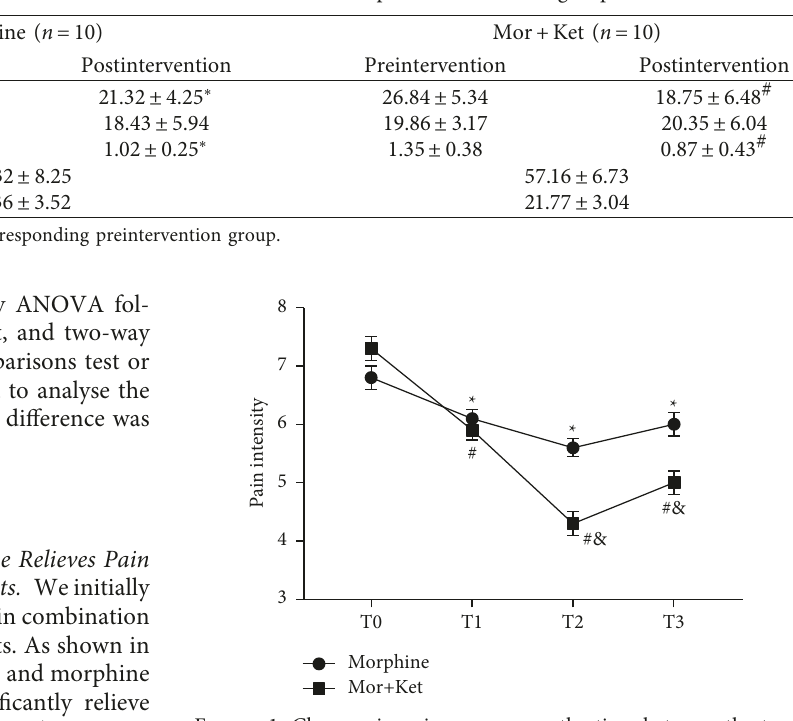
Table 1: Percentages of CD4 + and CD8 + and CD4 + /CD8 + ratio of the patients in the two groups.